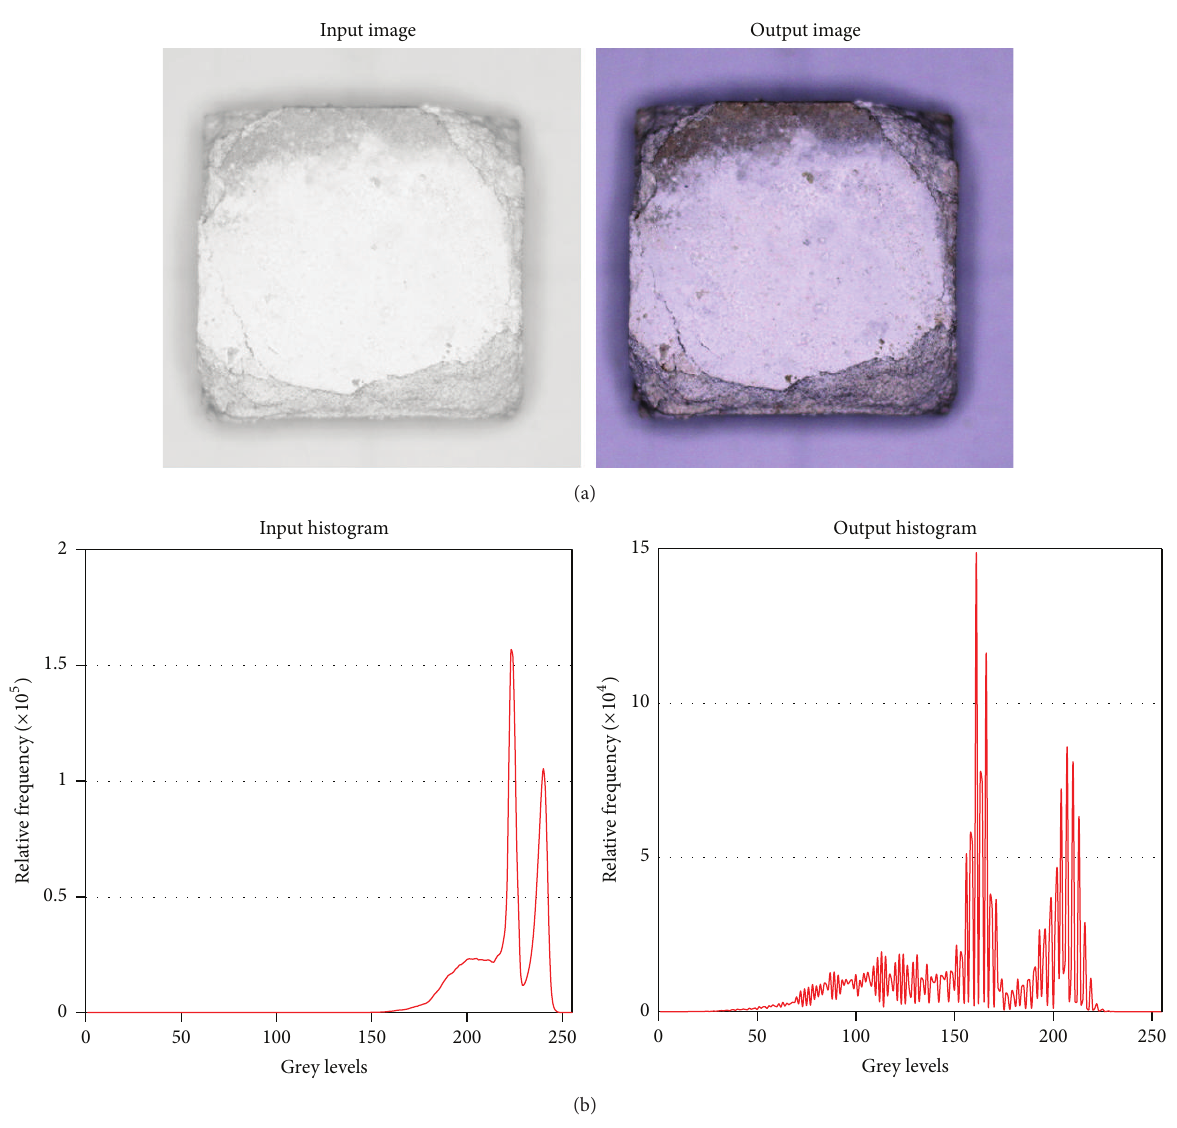
Figure 4: Histogram before and after contrast